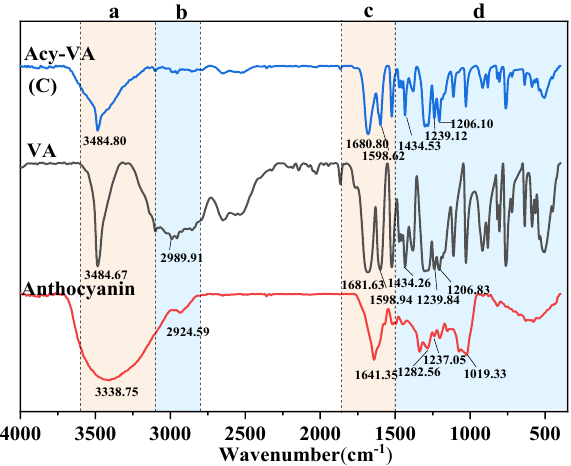
Figure 9. The Fourier transform infrared spectrum of anthocyanin derivatives co-pigmented between C3G and FA, CA, VA. ( A – C ) are the FTIR results of C3G-FA, C3G-CA, C3G-VA derivatives respectively.